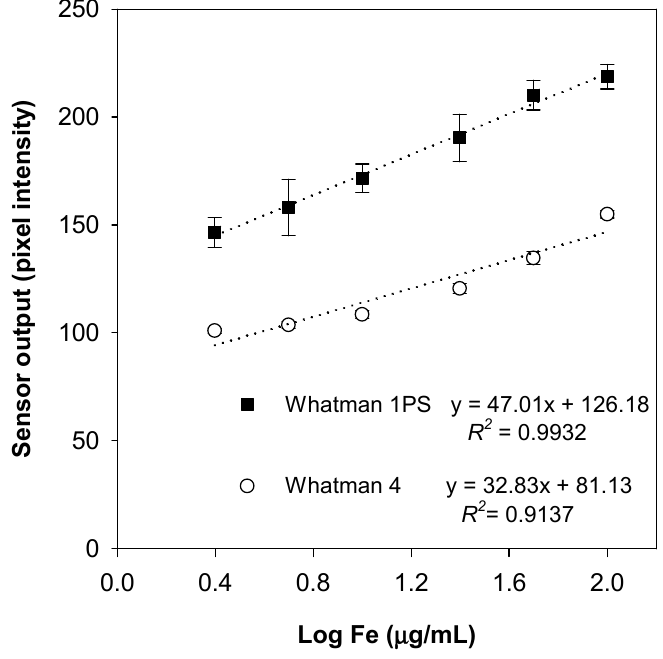
Figure 3. Iron standard curves using two paper platforms. Data points represent pixel characterization (Mean ± SD) as a response to iron concentrations (6 fortification levels, n = 5 of each) using Whatman 1PS and Whatman no. 4 papers.